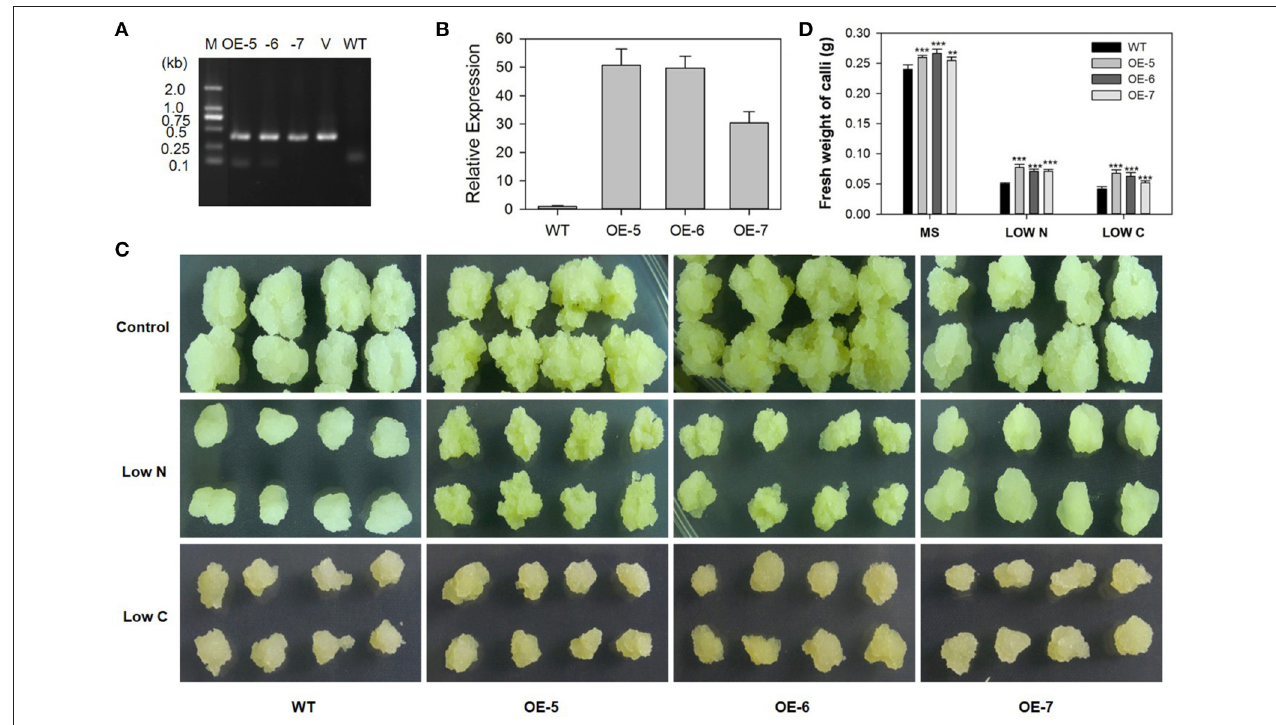
FIGURE 10 | Tolerance to limited supplies of nitrogen and carbon is enhanced by constitutive expression of MdATG8i in transgenic “Orin” apple callus. (A) PCR verification of constitutive expression. Lanes M, molecular marker DL2000; V, positive vector containing pGWB406- MdATG8i plasmid; WT, non-transformed wild-type; and OE-5 through -7, MdATG8i -transgenic callus lines; (B) qRT-PCR analysis of MdATG8i expression in WT and transgenic lines; (C) Morphology of callus after 20 days; (D) Fresh weights of callus after 20 days. Data are means ± SD of three biological replicates. * , ** or *** indicates the statistically significant differences determined by Student’s t -tests at P < 0.05, P < 0.01, or P < 0.001,